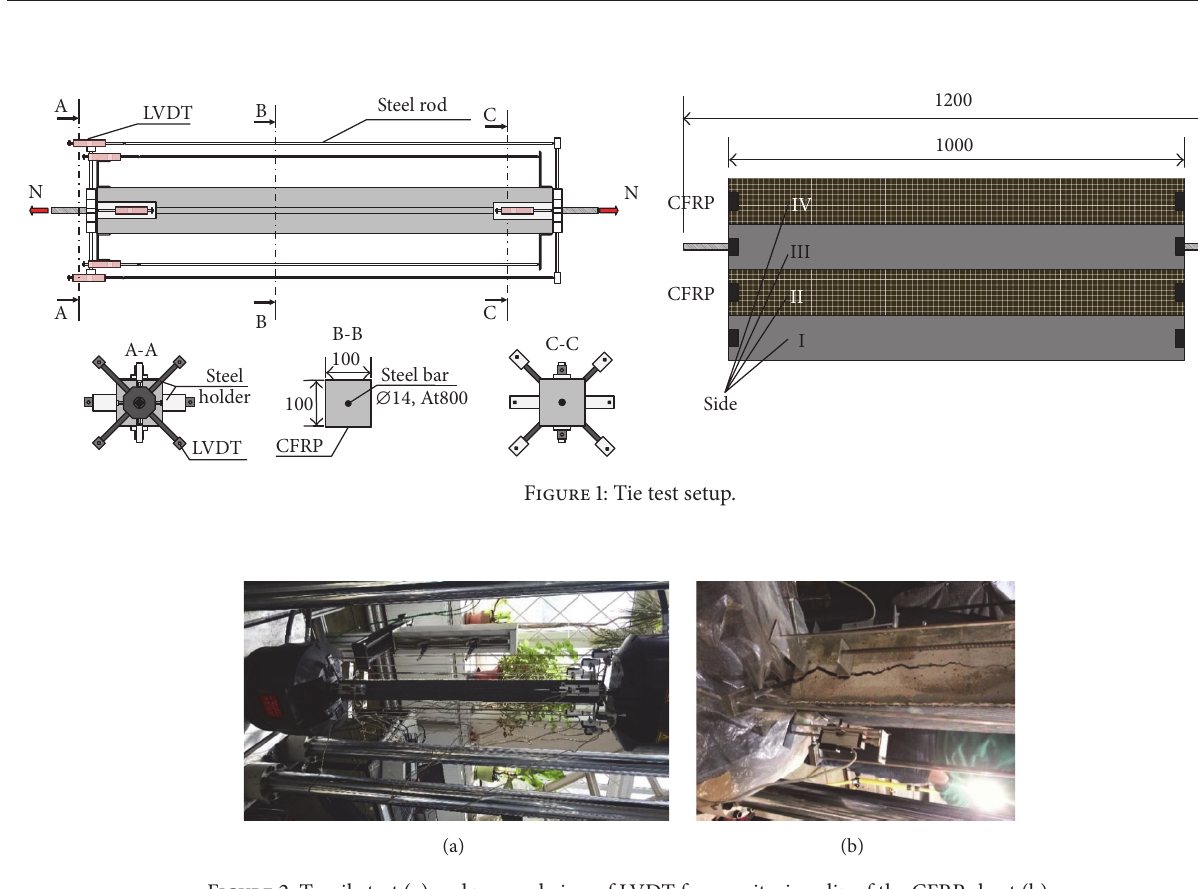
Figure 2: Tensile test (a) and zoomed view of LVDT for monitoring slip of the CFRP sheet